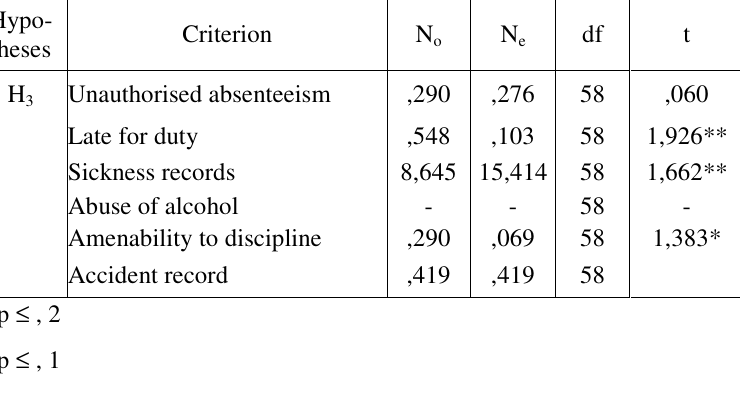
Test for Significance of Differences of Means for H : Complete Group (N 3